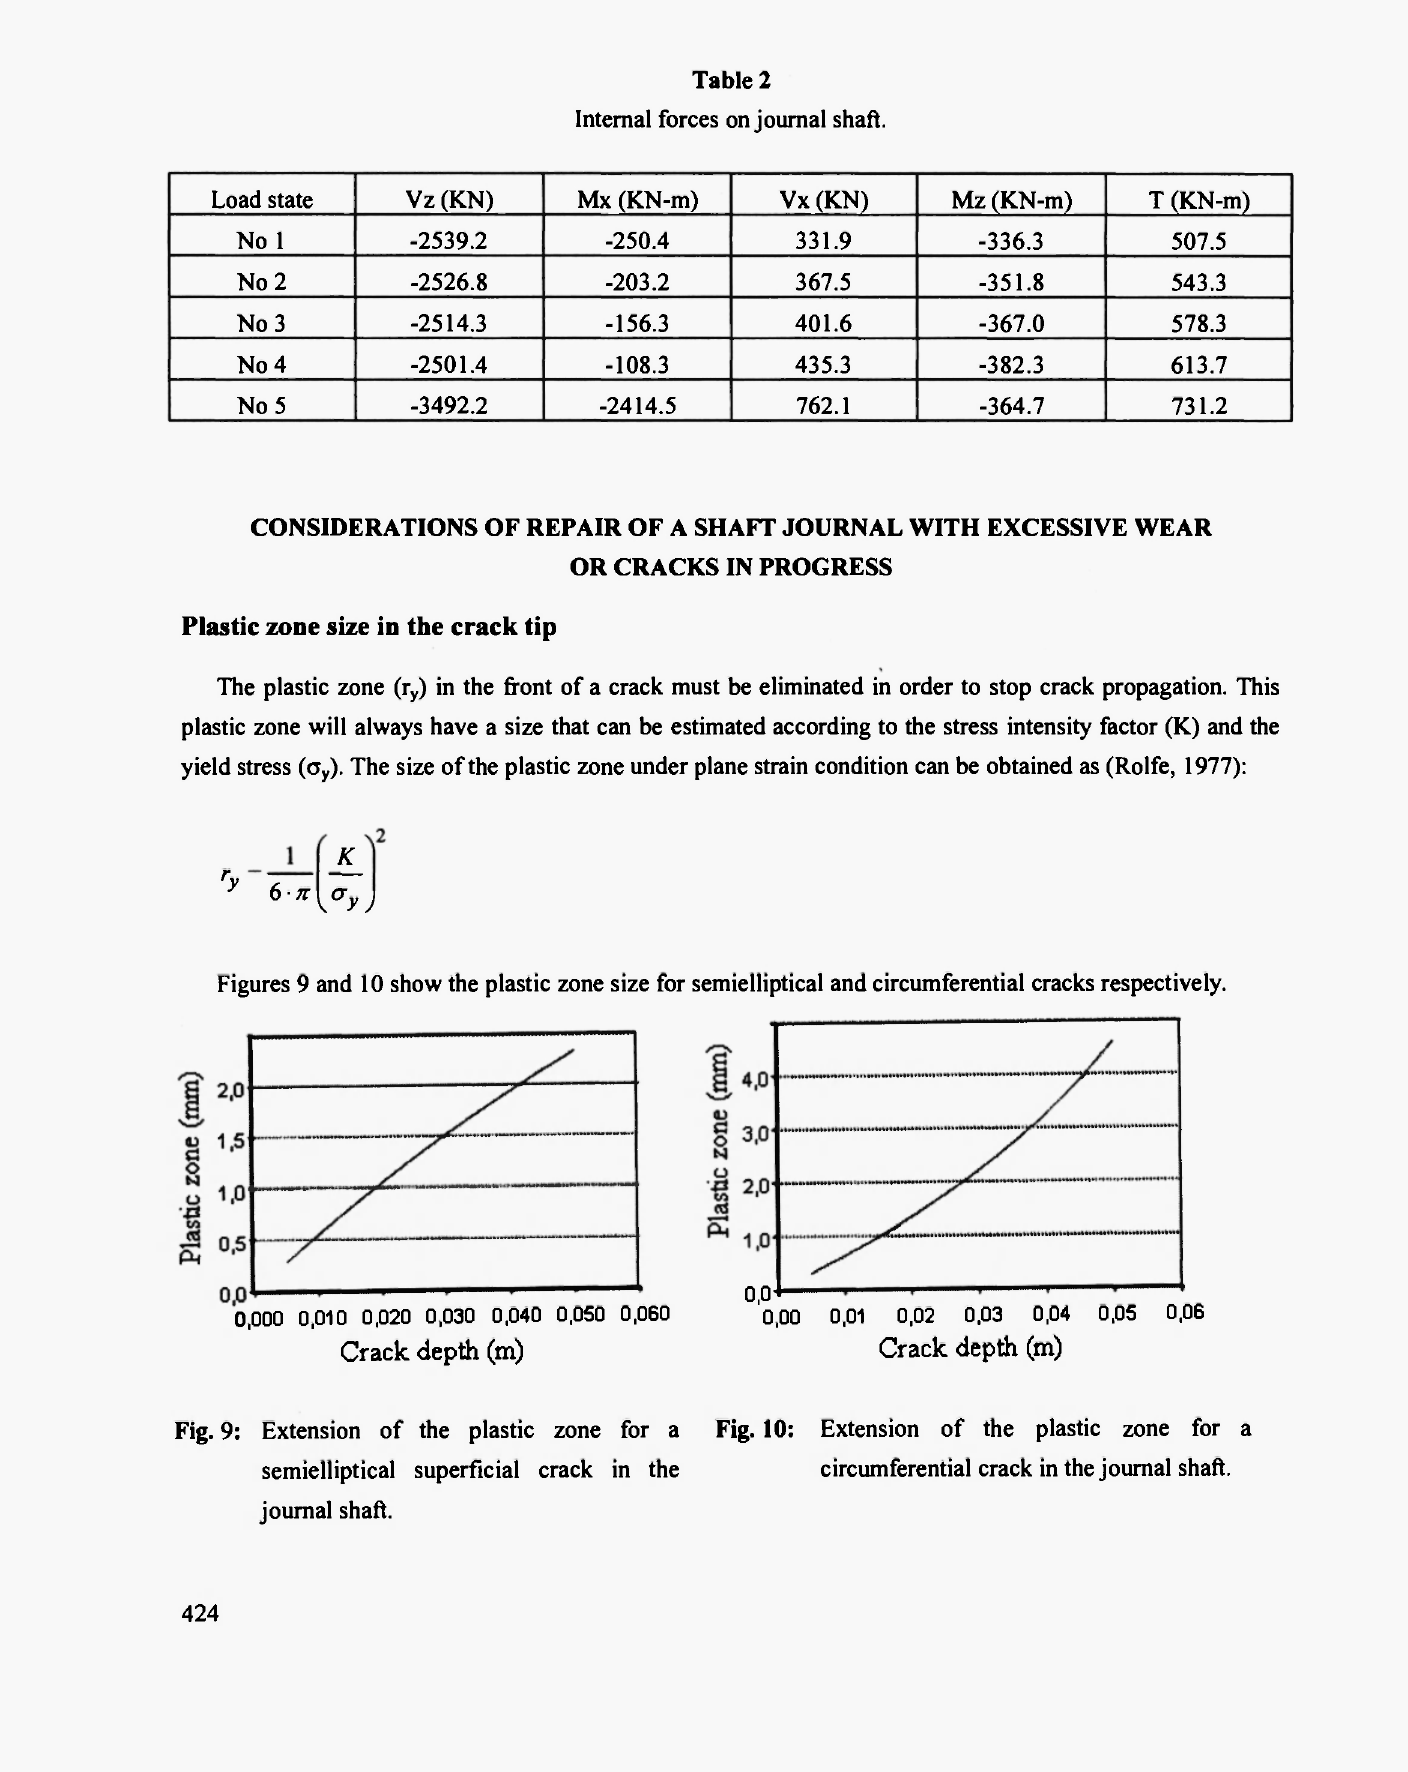
Fig. 10: Extension of the plastic zone for a circumferential crack in the journal